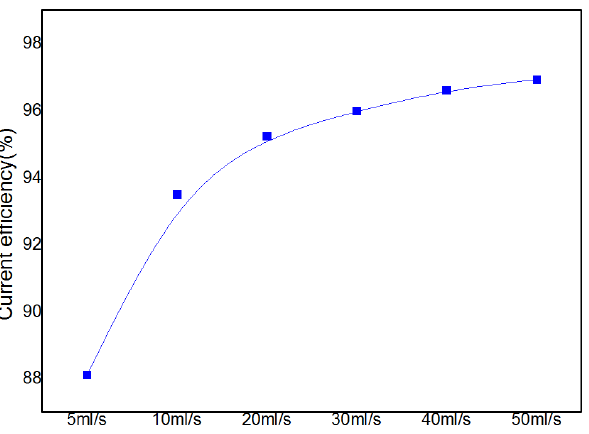
Figure 8. The current efficiency of cadmium sponge obtained at different flow rates.